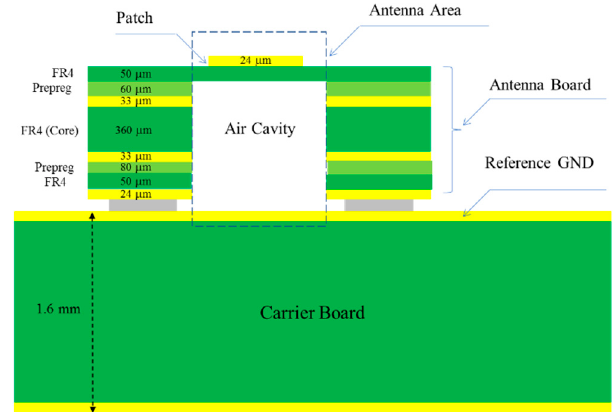
Figure 1. The structure of the patch antenna with air cavity.